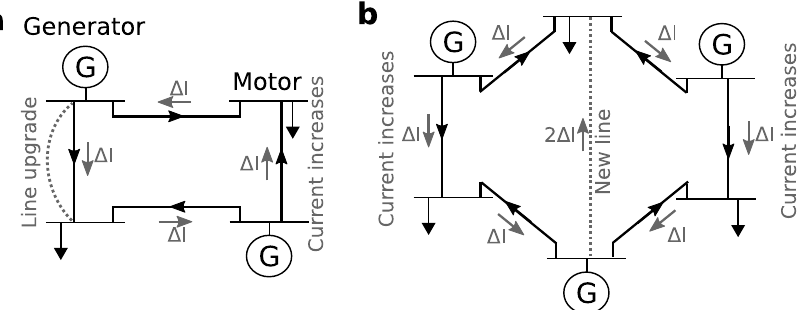
Fig. 1|SchematicofBraess ’ paradoxemergingfromupgrading orfromadding transmission lines. a Line upgrade in a four-node setup with two generators (G) and two loads, connected by a total of four lines. Original fl ows are indicated by black arrows and additional fl ows due to a line upgrade (dashed gray line) are